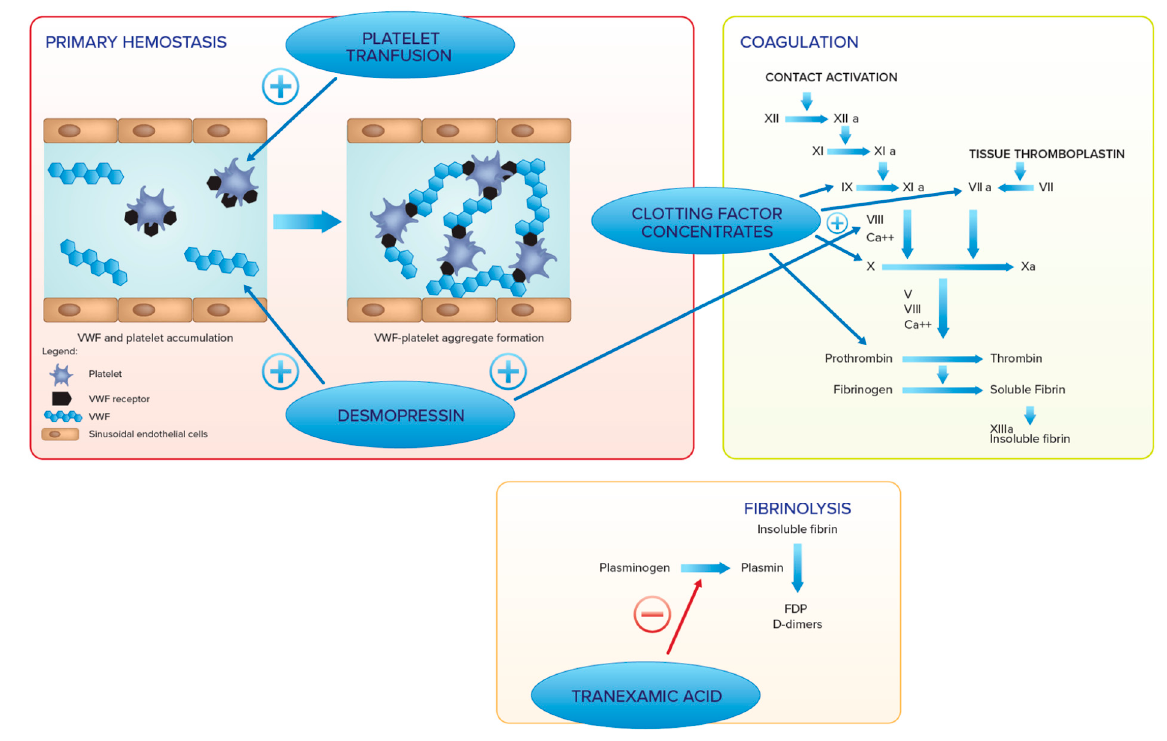
Figure 2. Therapeutic options to enhance hemostasis.